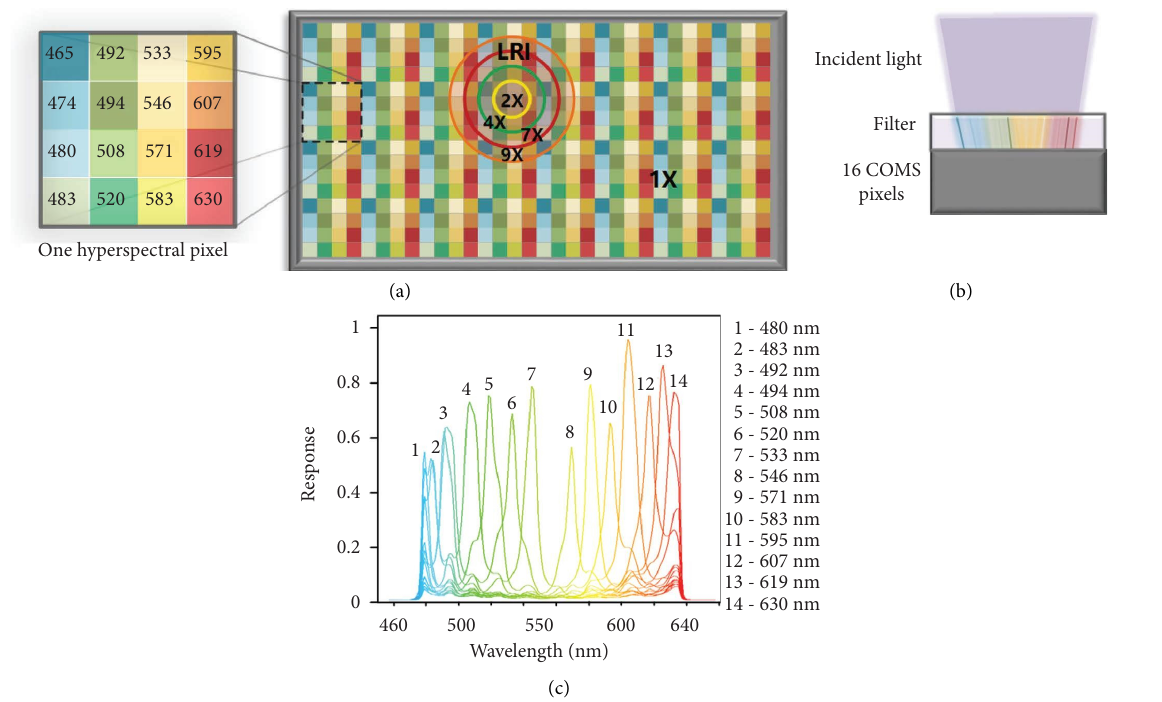
Figure 2: (a) Illustration of spectral images on mosaic CMOS and SRDA hyperspectral imaging pixel. (b) Illustration of one hyperspectral imaging pixel (16 CMOS pixels) with an FP flter. (c) Spectral responses of the 14 wavelength